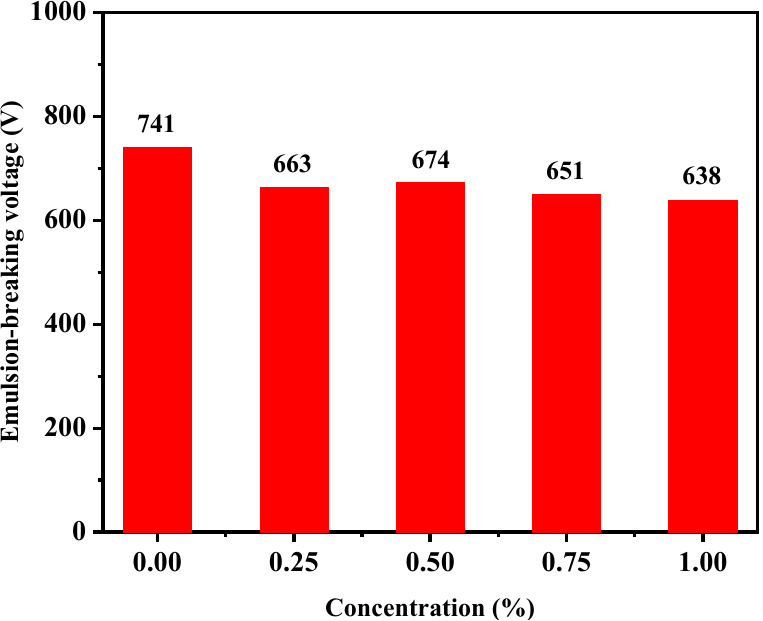
Figure 7. Emulsion-breaking voltage change curve after aging of oil-based drilling fluids with the addition of poly (MMA-BA-ST).